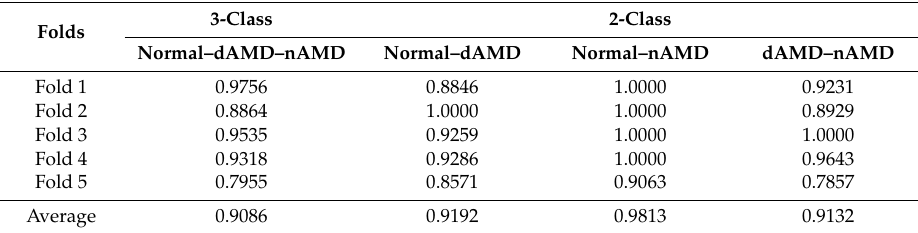
Table 2. Results obtained using five-fold cross-validation with preprocessing.